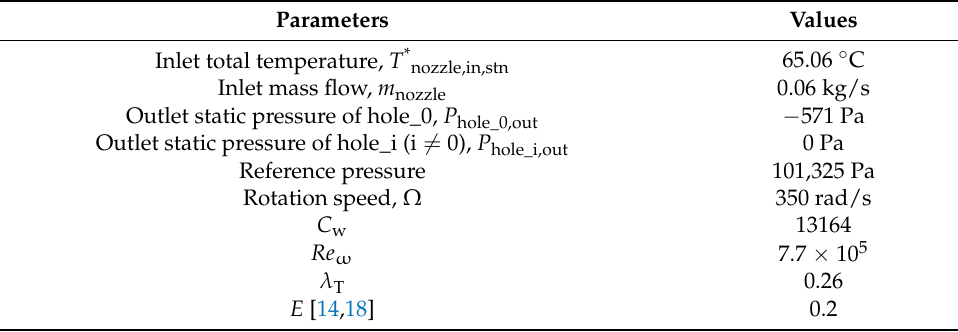
Figure 2. Computational model. Table 3. Boundary